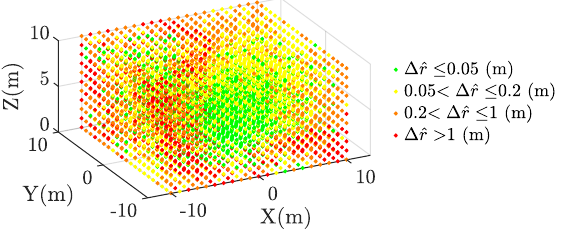
Figure 3. Example of source emitter radius error ∆ ˆ r analysed with MLE-hyperbolic least squares (HLS) under time sampled digitizing error conditions.